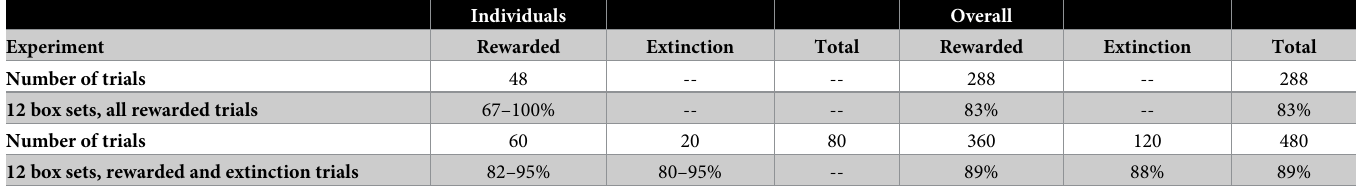
Table 2. Training sessions using 12 box sets (1 box set of 5 boxes per trial) with all rewarded trials or 12 box sets and extinction trials